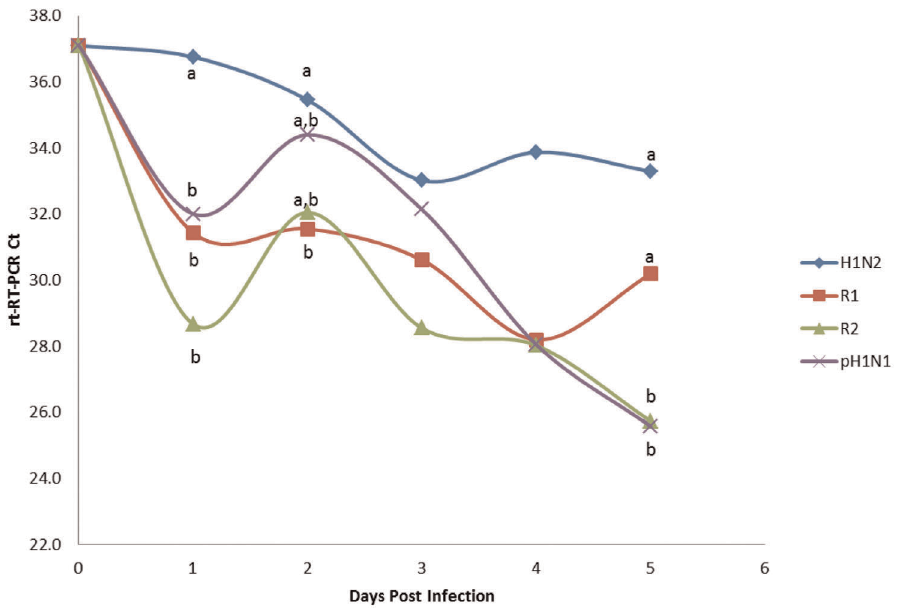
Figure 4. Four pigs were each challenged intranasally with 2 mL of 6.2 log10 TCID50/mL with H1N2, pH1N2, R1 or R2. Nasal swabs were collected daily and analyzed by rt-RT-PCR for virus shedding. RT-PCR data on day 0 reflect swabs collected prior to inoculation. Data represent the mean Ct value for the four nasal swabs collected at each time point. Samples with different subscripts at a time point are statistically different (P , 0.05). Detection limit of rt-RT-PCR assay used in this study is approximately 1 infectious particle of SIV.